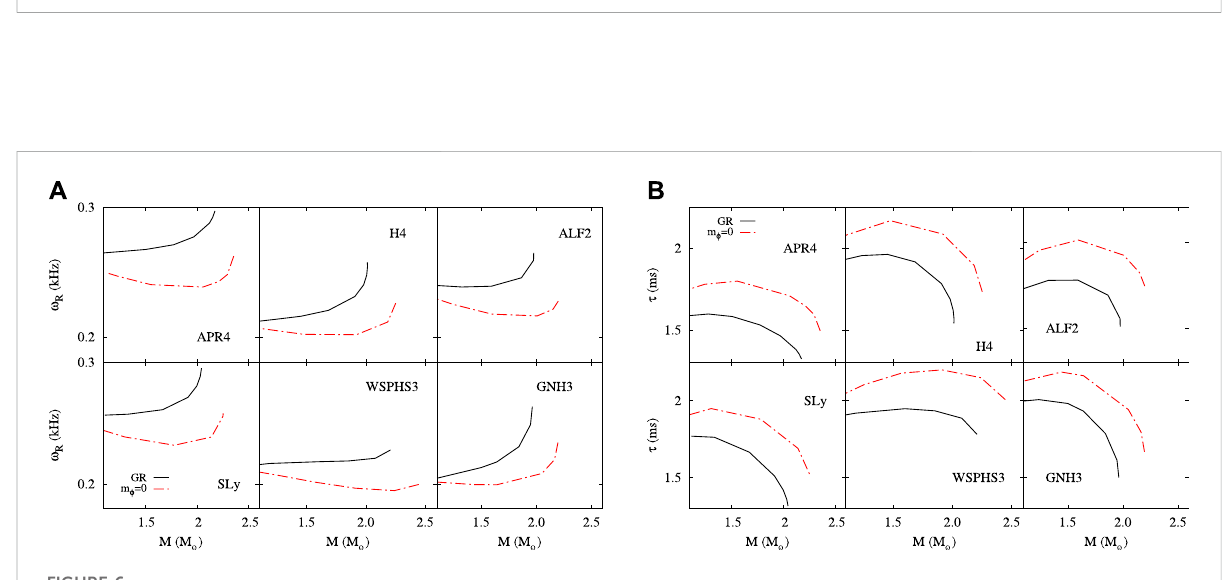
FIGURE 6 Frequency ω R inkHz (A) anddampingtime τ inmilliseconds (B) versus neutronstarmass M in M ⊙ forthedipole ϕ -mode.Thesixpanelsrepresent six equations of state, and the color red indicates the massless case, with the general relativistic case in